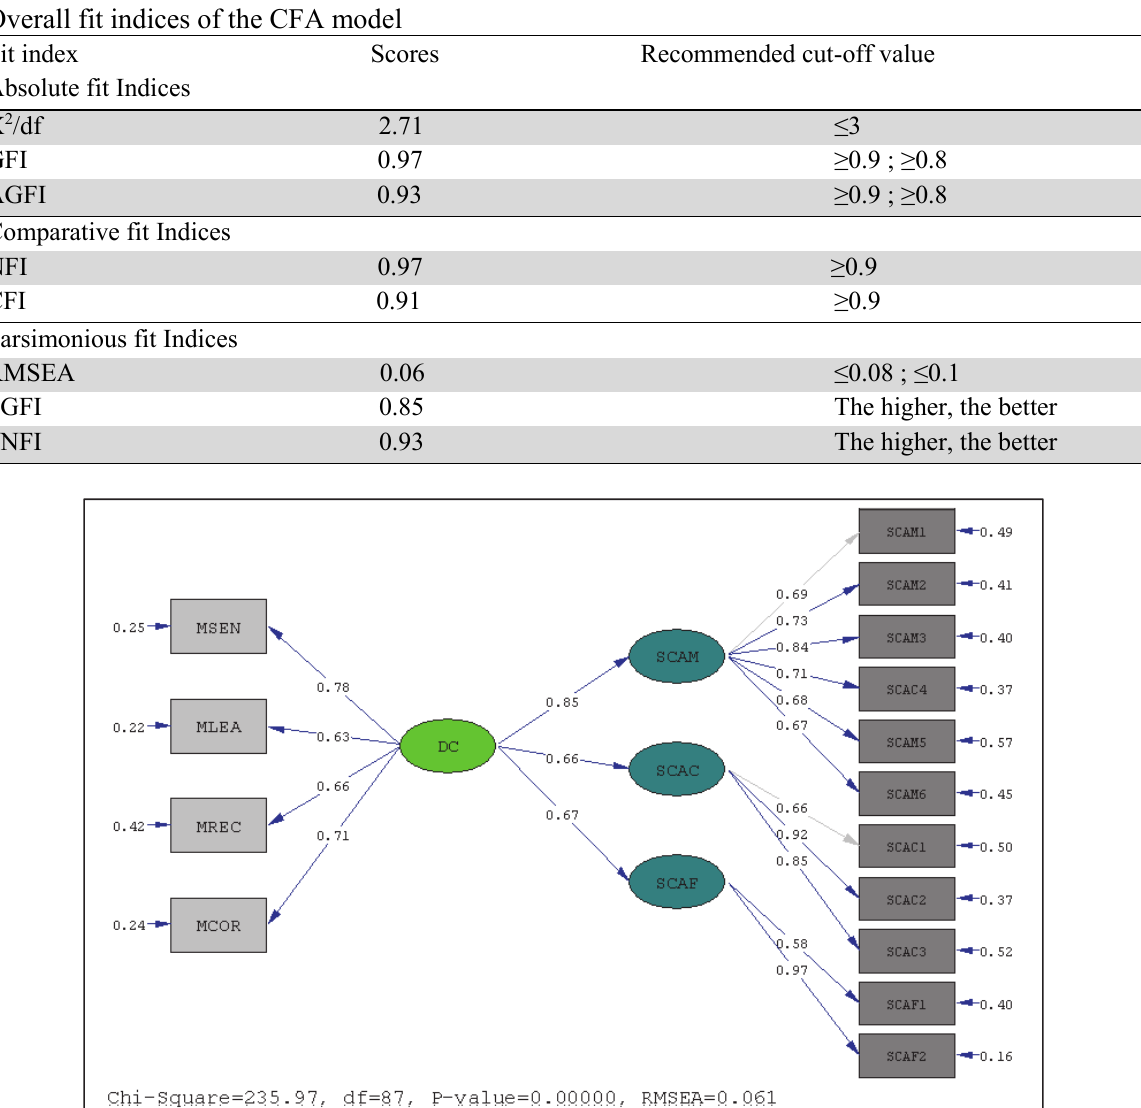
Fig.3. Structural Relationship model between DC and